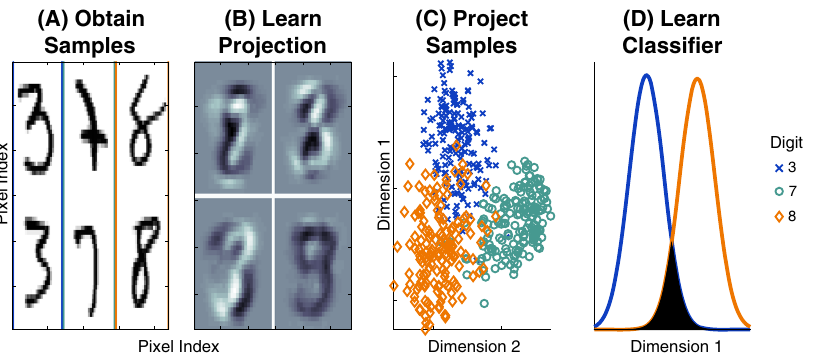
Fig. 4 Schematic illustrating linear optimal low-rank ( LOL ) as a supervised manifold learning technique. A 300 training samples of the numbers 3, 7, and 8 from the MNIST dataset (100 samples per digit); each sample is a 28 × 28 = 784 dimensional image (boundary colors are for visualization purposes). B The fi rst four projection matrices learned by LOL . Each is a linear combination of the sample images. C Projecting 500 new (test) samples into the top two learned dimensions; digits color coded as in ( A ). LOL -projected data from three distinct clusters. D Using the low-dimensional data to learn a classi fi er. The estimated distributions for 3 and 8 of the test samples (after projecting data into two dimensions and using LDA to classify) demonstrate that 3 and 8 are easily separable by linear methods after LOL projections (the color of the line indicates the digit). The fi lled area is the estimated error rate; the goal of any classi fi cation algorithm is to minimize that area. LOL is performing well on this high-dimensional real data